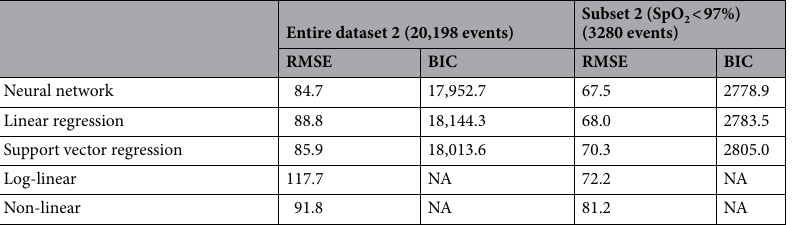
Entire dataset 2 (20,198